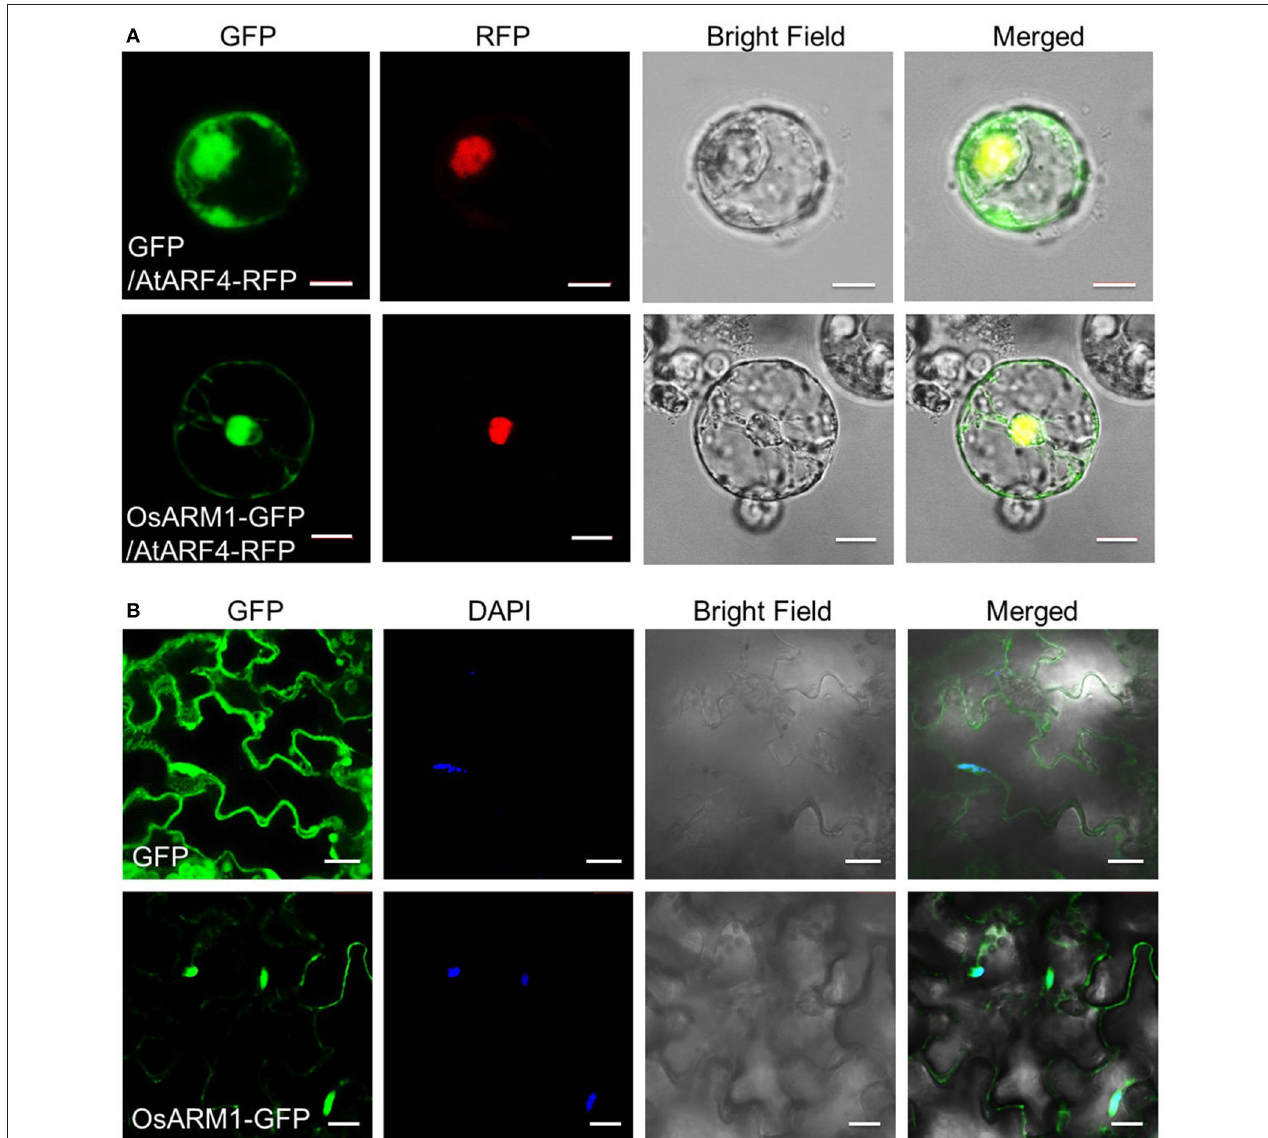
FIGURE 3 | OsARM1-GFP mainly localizes to the nucleus. (A) 8-day-old rice green seedlings (stem and sheath) were used for protoplast isolation. The 35S::GFP empty vector pBI-eGFP and nuclear marker AtARF4-RFP or vector 35S::OsARM1-GFP and AtARF4-RFP were transiently co-expressed in protoplasts. Bars = 10 µ m. (B) Leaf epidermal cells from 1-week-old transgenic Arabidopsis expressing the OsARM1-GFP fusion protein were examined by confocal microscopy. Before confocal observation, the Arabidopsis leaves were infiltrated with PBS (pH 7.4) containing 2 ng/ µ L DAPI for 10min. Bars = 20 µ m. OsARM1-GFP was